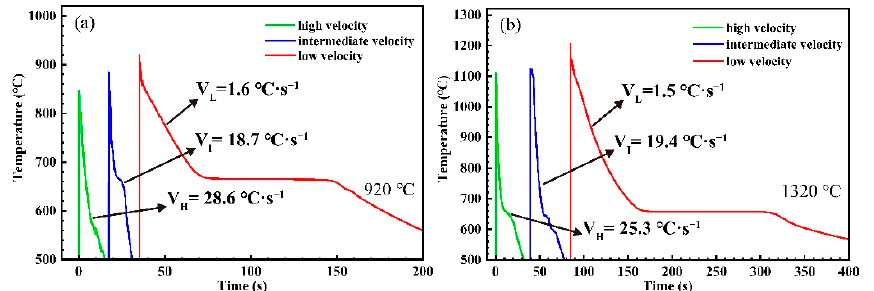
Figure 3. Cooling curves at the different remelting conditions: ( a ) remelting temperature of 920 ◦ C; ( b ) remelting temperature of 1320 ◦ C.